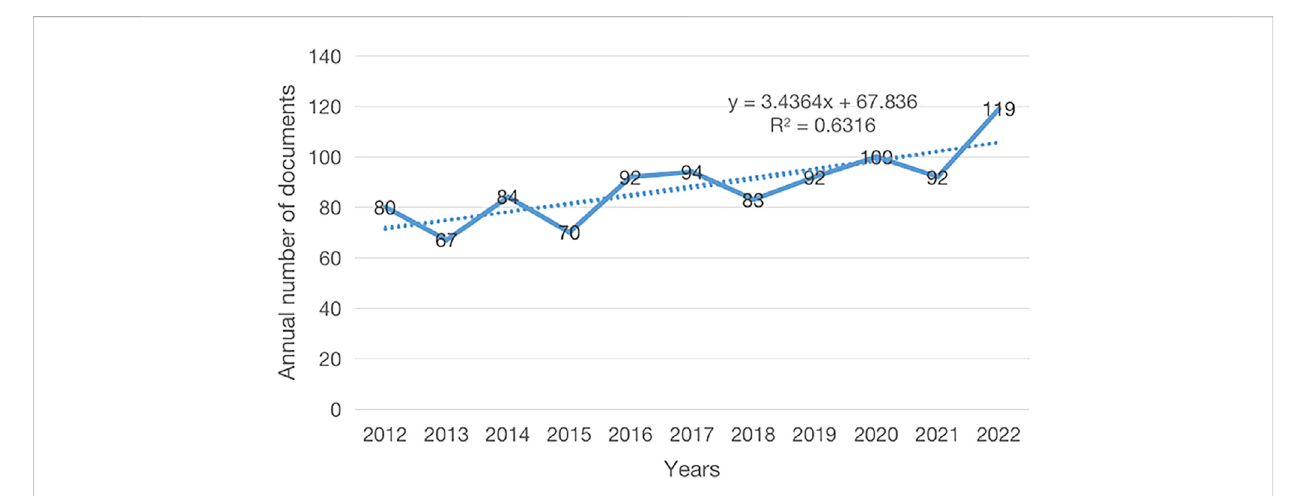
FIGURE 2 Published trend chart concerning IBS and the visceral